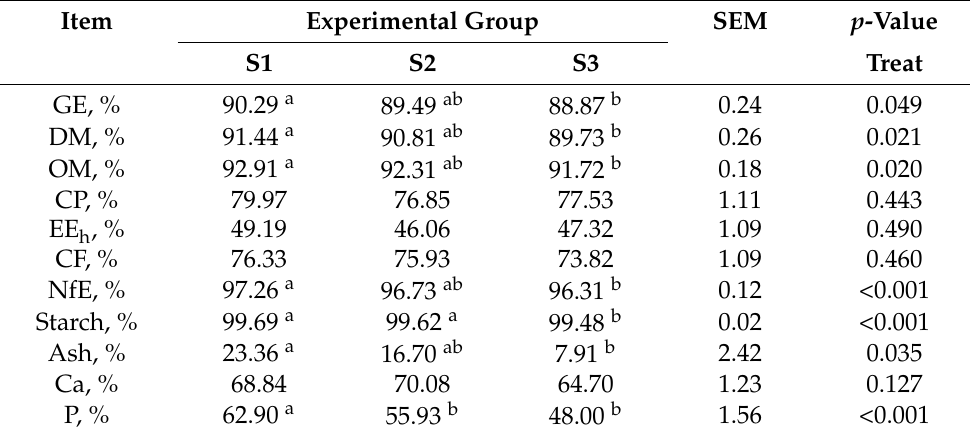
Table 3. Effects of sorghum conserves with varying dry matter concentrations (701, 738 and 809 g kg − 1 ) on apparent total tract digestibility (%) of energy, crude nutrients and minerals in diets for growing pigs ( n =